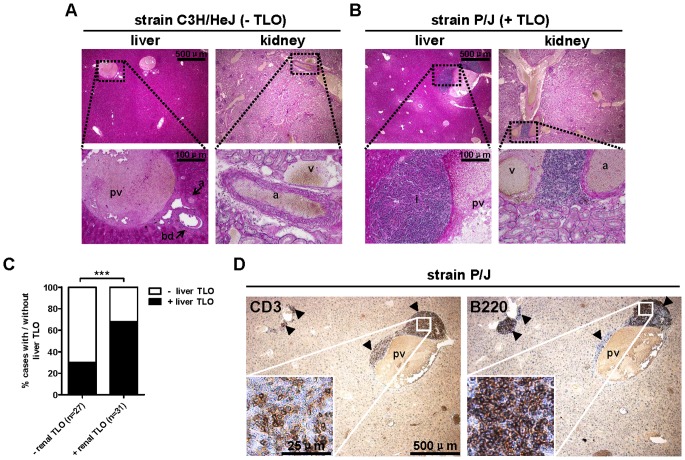
Renal TLO formation is associated with perivascular infiltrates in the liver.Four strains with relative absence (BALB/cByJ [n = 9], C3H/HeJ [n = 10], RIIIS/J [n = 10], C57BLKS/J [n = 10]) and four strains with relative abundance (BTBR T+ tf/J [n = 7], C57L/J [n = 9], P/J [n = 8], LP/J [n = 4]) of renal TLOs were analyzed for the presence of perivascular infiltrates in the liver. (A) PAS staining on C3H/HeJ kidney and liver without perivascular infiltrates (magnifications: 40x and 200x). (B) PAS staining on P/J kidney and liver with perivascular infiltrates (magnifications: 40x and 200x). (C) 21/31 (67.7%) of mice with renal TLOs contained liver TLOs, whereas 8/27 (29.6%) of mice without renal TLOs contained liver TLOs (Pearson's χ2 test, P<0.0001). (D) The perivascular infiltrates in liver consisted of CD3+ T cells and B220+ B cells (magnification: 40x). Insets show high-power magnifications of the indicated areas. Arrowheads indicate positively stained cell clusters. Abbreviations: a: arteriole, bd: bile duct; i: infiltrate; pv: portal vein, v: vein.